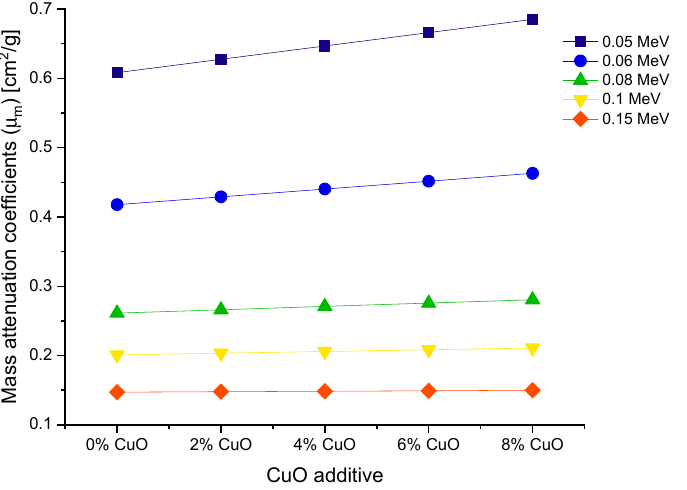
Materials 2021 , 14 , x FOR PEER REVIEW Figure 5. Variation of mass attenuation coefficient ( µ m ) against photon energy for VPB x Cu y glass samples. Figure 5. Variation of mass attenuation coefficient ( μ m ) against photon energy for VPB x Cu y glass samples.